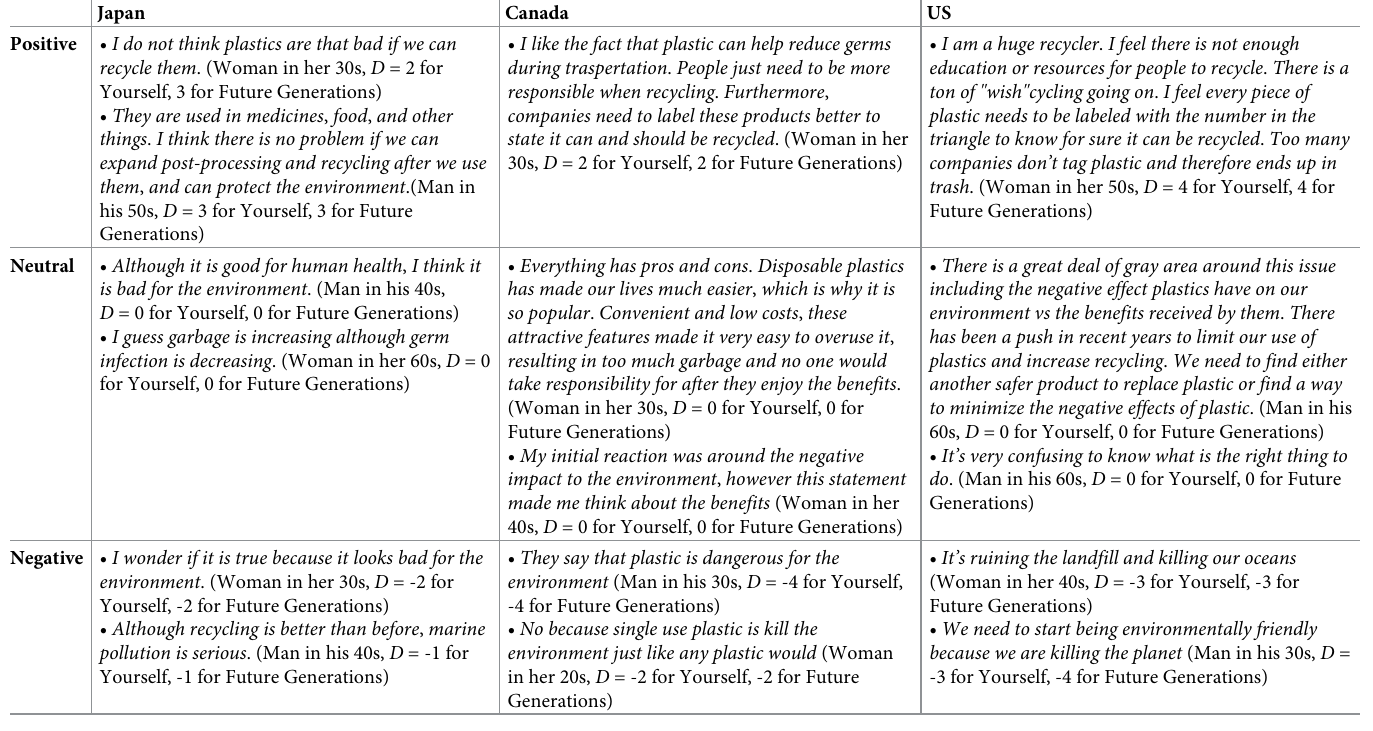
Table 7. Characteristic responses for